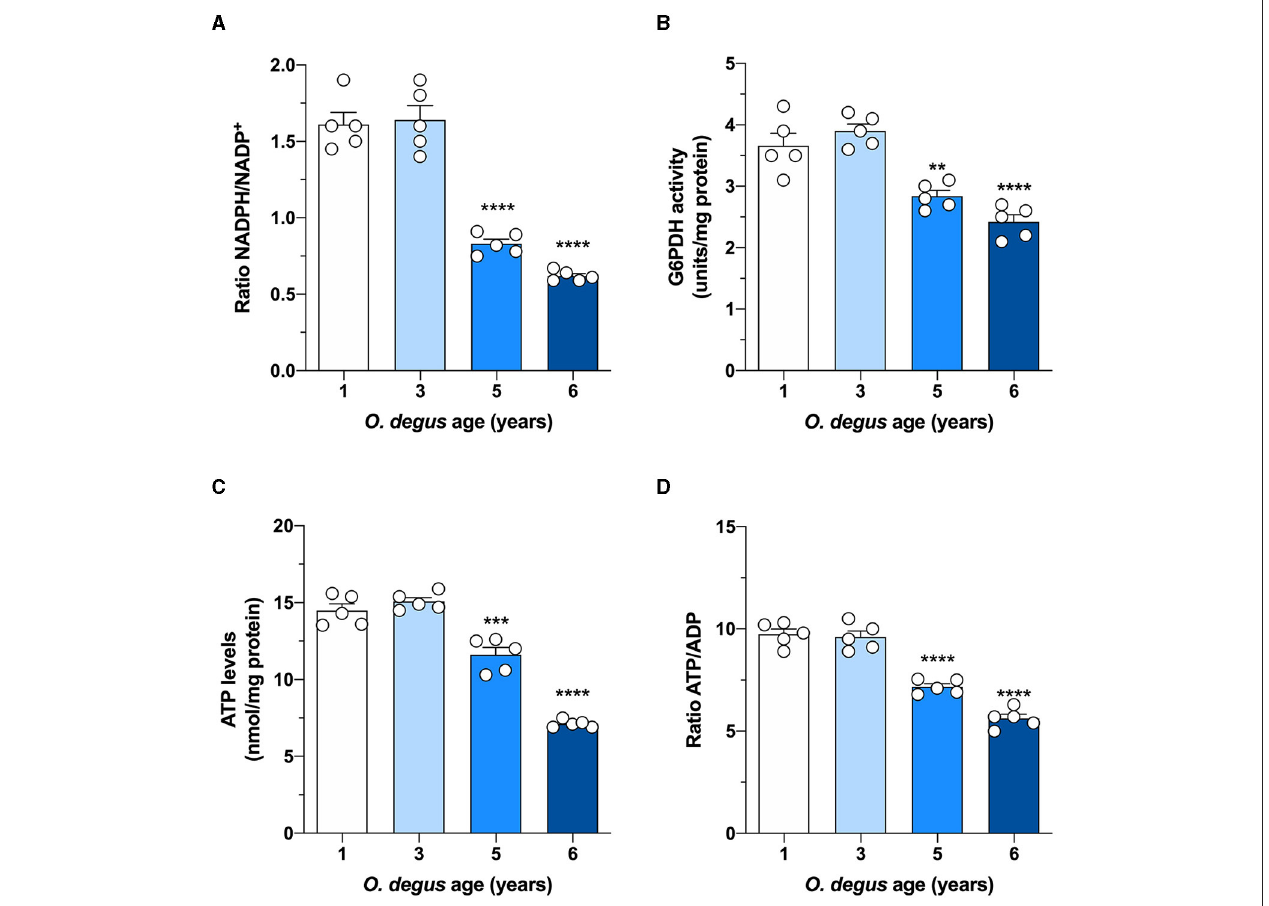
FIGURE 4 | Effect of age on glucose metabolism in degus. Hippocampal slices from 1- to 6-year-old degus were used to assess (A) the NADPH/NADP + ratio, (B) glucose-6-phosphate dehydrogenase (G6PDH) activity, (C) total ATP, and (D) the ATP/ADP ratio. The data represent the mean ± SEM of five independent biological replicates in three technical replicates. Statistical significance: ** p < 0.01, *** p < 0.001, and **** p < 0.0001, by one-way ANOVA, followed by Bonferroni’s post-hoc